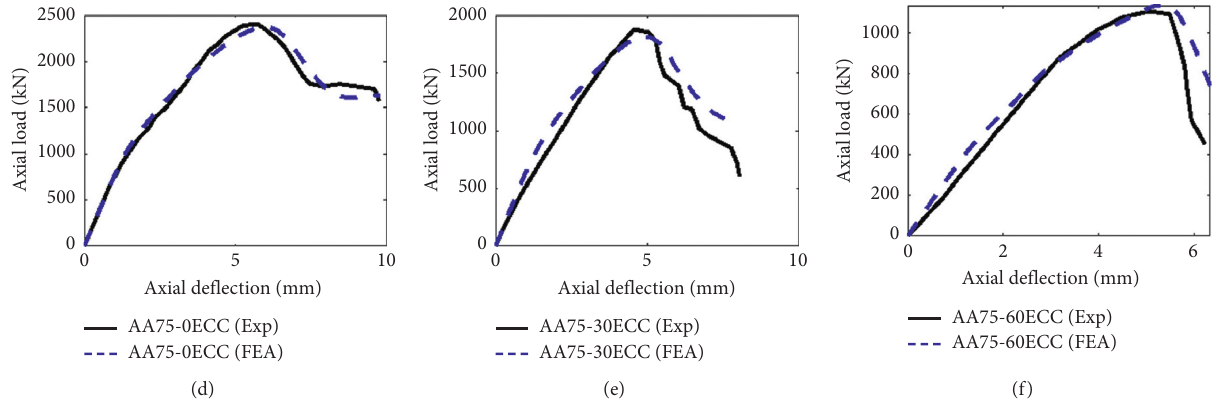
Figure 11: Comparison of load-deflection curves of GFHF columns obtained from FEM and experiments. PE, max. principal (avg: 75%)